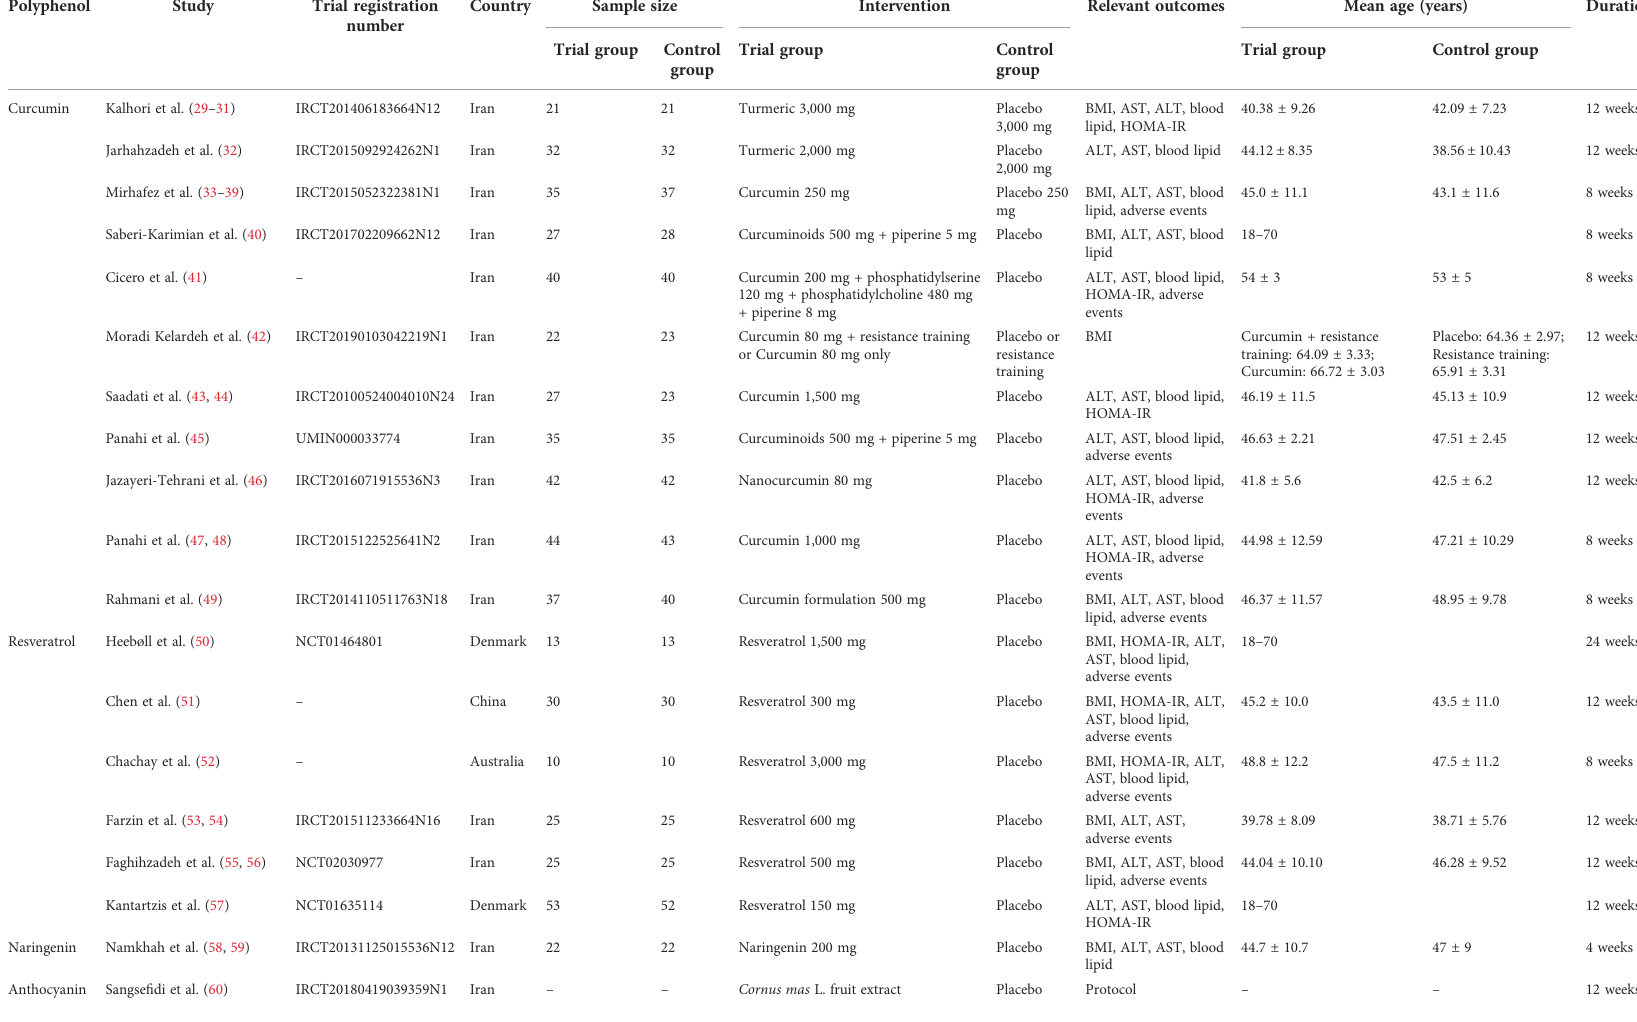
TABLE 1 The characteristics of the included studies. Polyphenol